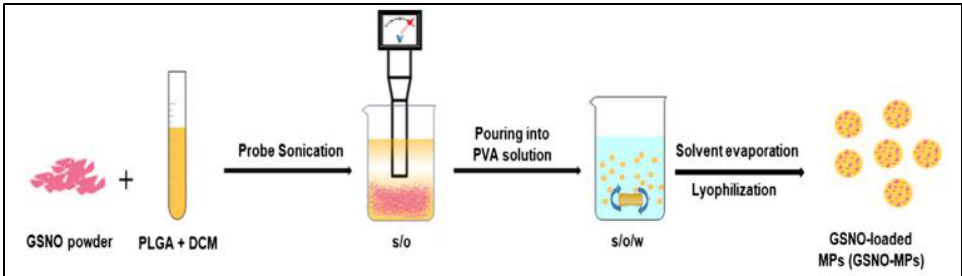
Figure 3. Schematic illustration of preparation of GSNO-MPs [36].